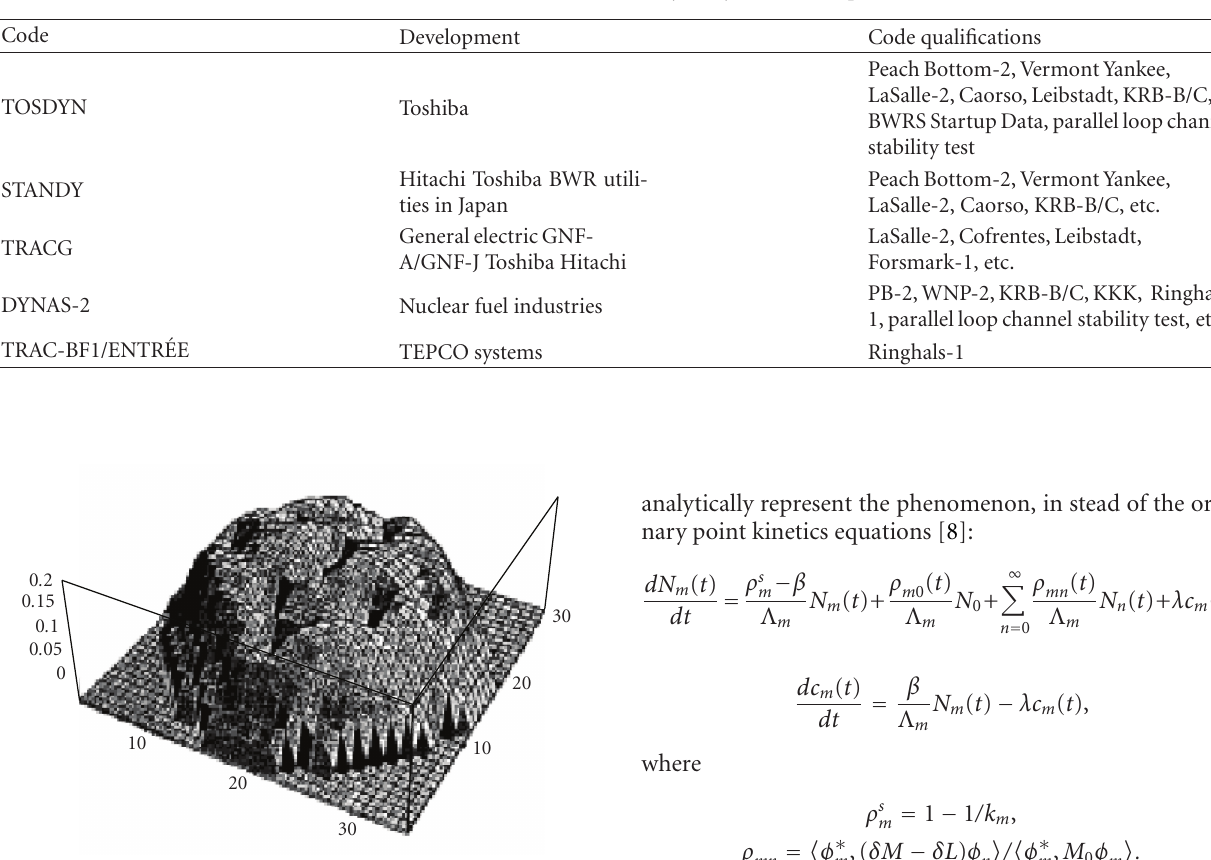
Table 2: Three-dimensional stability analysis code in Japan.